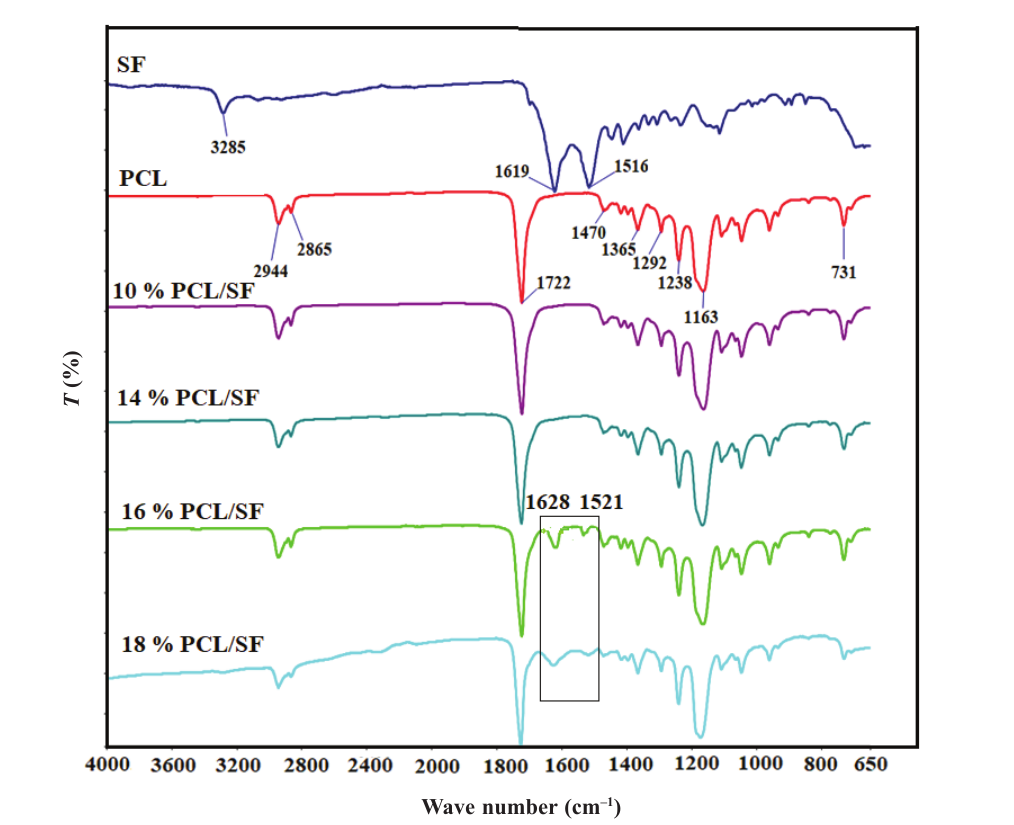
Fig. 2 – FTIR-ATR spectra of SF, electrospun PCL, and PCL/SF scaffolds